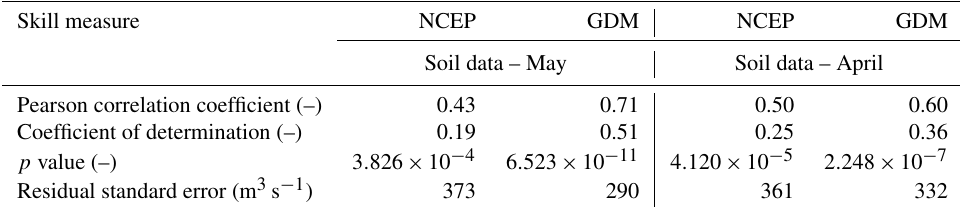
Table 3. Statistics for the forecast models based on NCEP and GDM soil moisture data for forecasted lowest 7-day mean flow MoNM 7 Q of June at gauge Kaub/Rhine (period